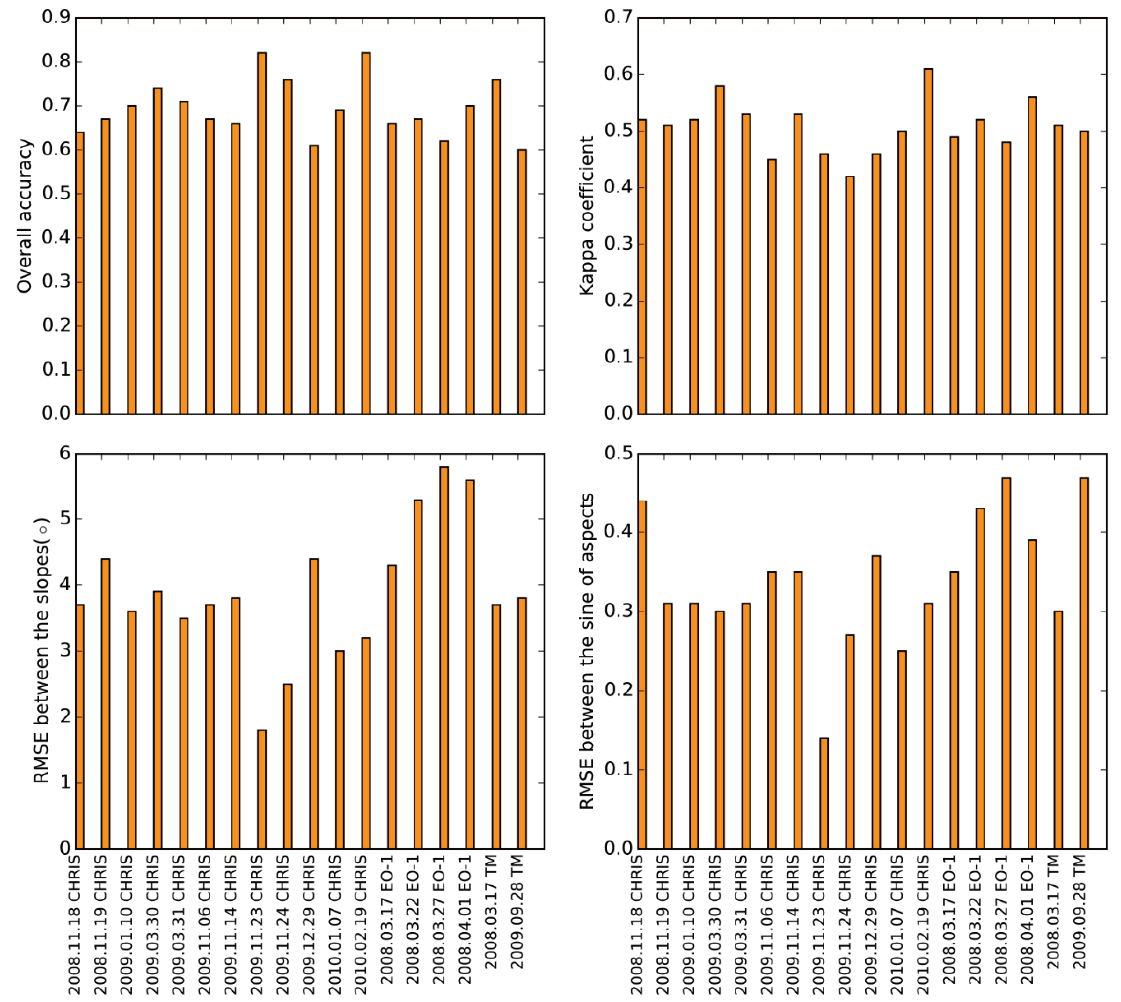
Figure 8. Accuracies of the downscaled snow map for different periods assuming K is 0.009. The X-coordinate is different image sources. For example, “2008.11.18 CHRIS” means the snow map from CHRIS data in 18 November 2008. The Y-coordinates are overall accuracy, kappa coefficient, RMSE between the slopes of real high-resolution snow map and downscaled snow map and RMSE between the sine of aspects of real high-resolution snow map and downscaled snow